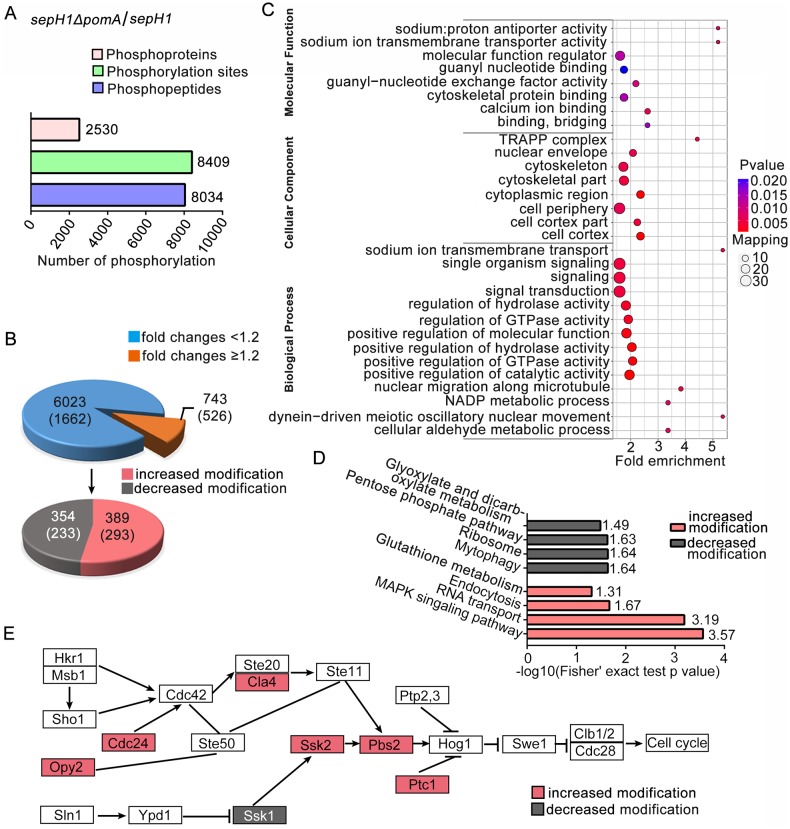
Quantitative phosphoproteomics comparison between the septa-restored strain sepH1ΔpomA (ZXA10) and the septa-abolished control strain sepH1 revealed that the deletion of pomA activated the HOG pathway.(A) Total number of detected phosphorylation sites, peptides and proteins and (B) fold changes of phosphorylated proteins. (C) GO terms enriched for all phosphorylated proteins and (D) KEGG pathways enriched in phosphorylated proteins with more than 1.2-fold changes. (E) Visual analysis of the increased phosphorylated proteins in the MAPK pathway (labeled in red).